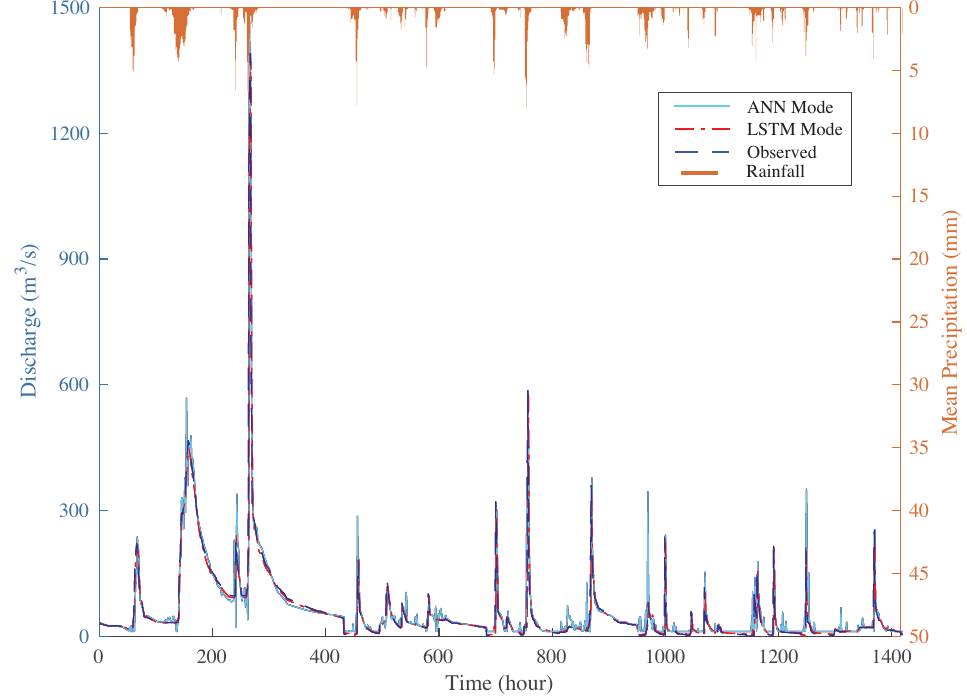
Figure 6. The observed and estimated hydrographs (12 flood events of validation) using ANN and LSTM models.